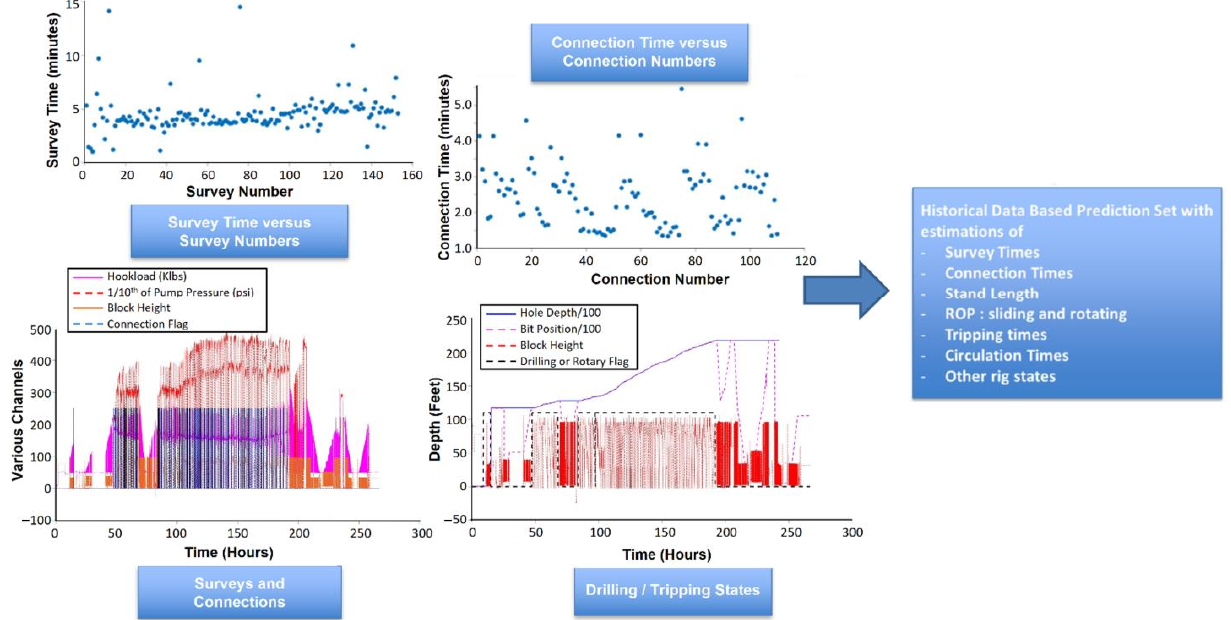
Figure 10. Subset of the data collected from each offset well for deriving a priori initializations.